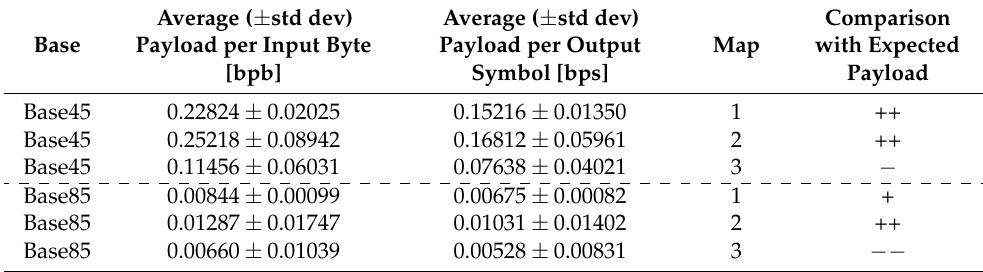
Table 3. Results of the Base45 and Base85 encodings applied to 500 TIFF colour images (average image size 1297.4 KB).